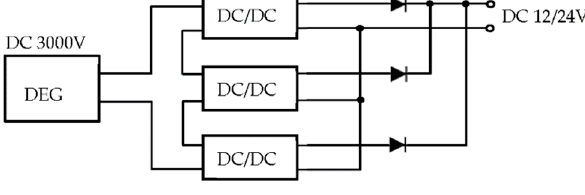
Figure 6. The 1000 V DC/DC converter.